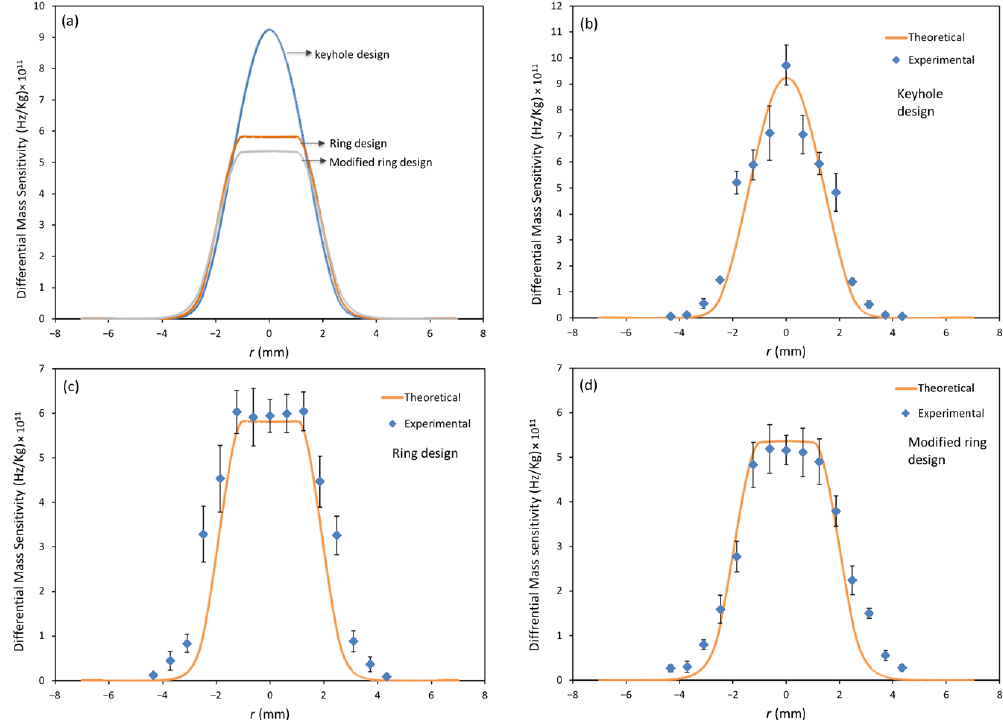
Figure 4. ( a ) Comparison of mass sensitivity distribution of 6 MHz Plano-Plano resonator for keyhole design ( R = 0.006), ring electrode ( R = 0.006), and modified ring electrode ( R = 0.0045). Calculated and experimental data of mass sensitivity distribution as a radial location from the center of 6 MHz Plano-Plano resonator designs: ( b ) keyhole ( R = 0.006), ( c ) ring electrode ( R = 0.006), and ( d ) modified ring electrode ( R = 0.0045).